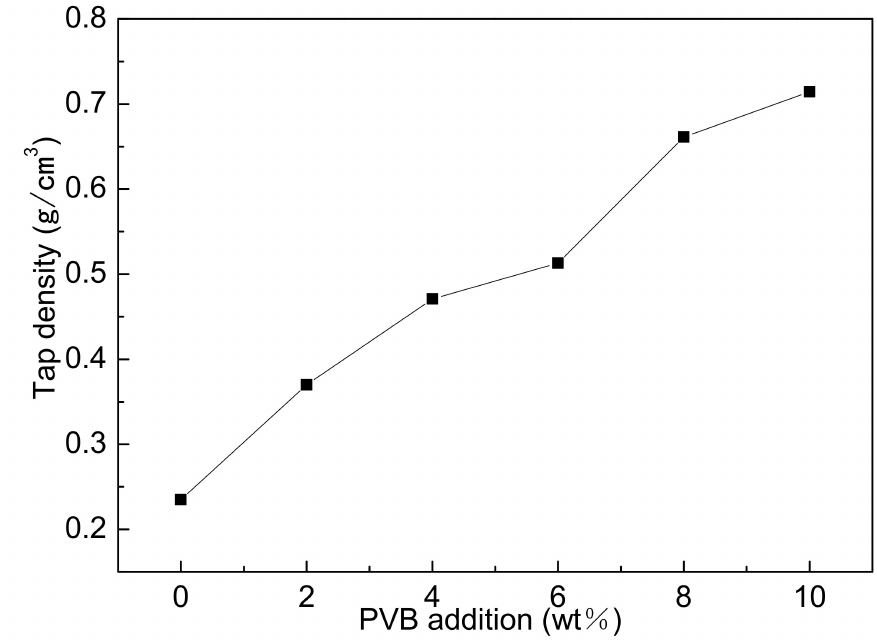
Figure 3. Tap densities of Al(OH) 3 /carbon black powders with different PVB